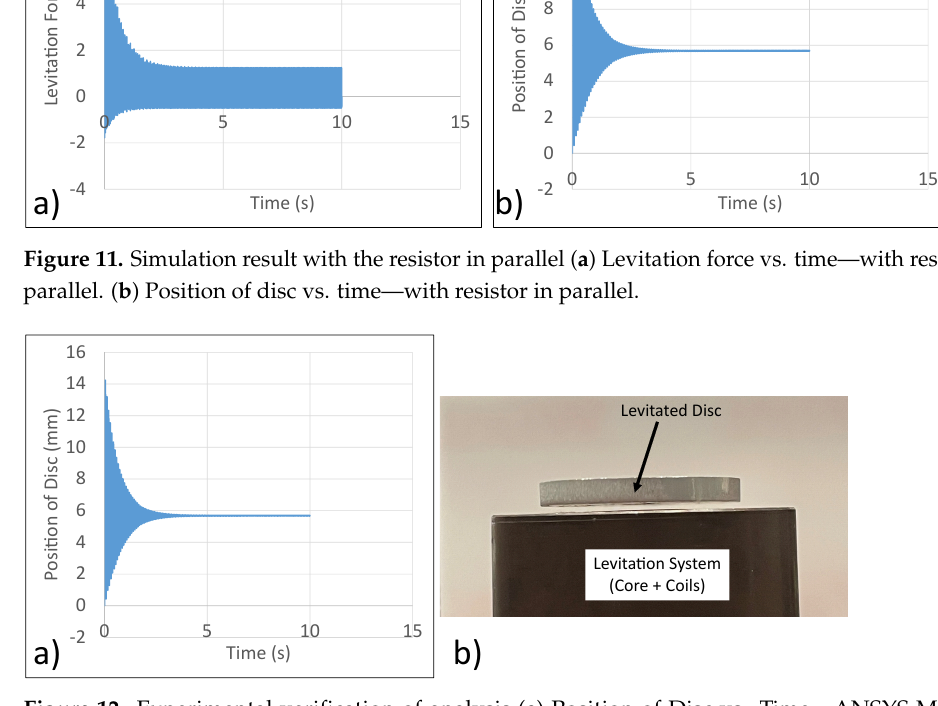
Figure 12. Experimental verification of analysis ( a ) Position of Disc vs. Time—ANSYS Maxwell. ( b ) Steady State Position of